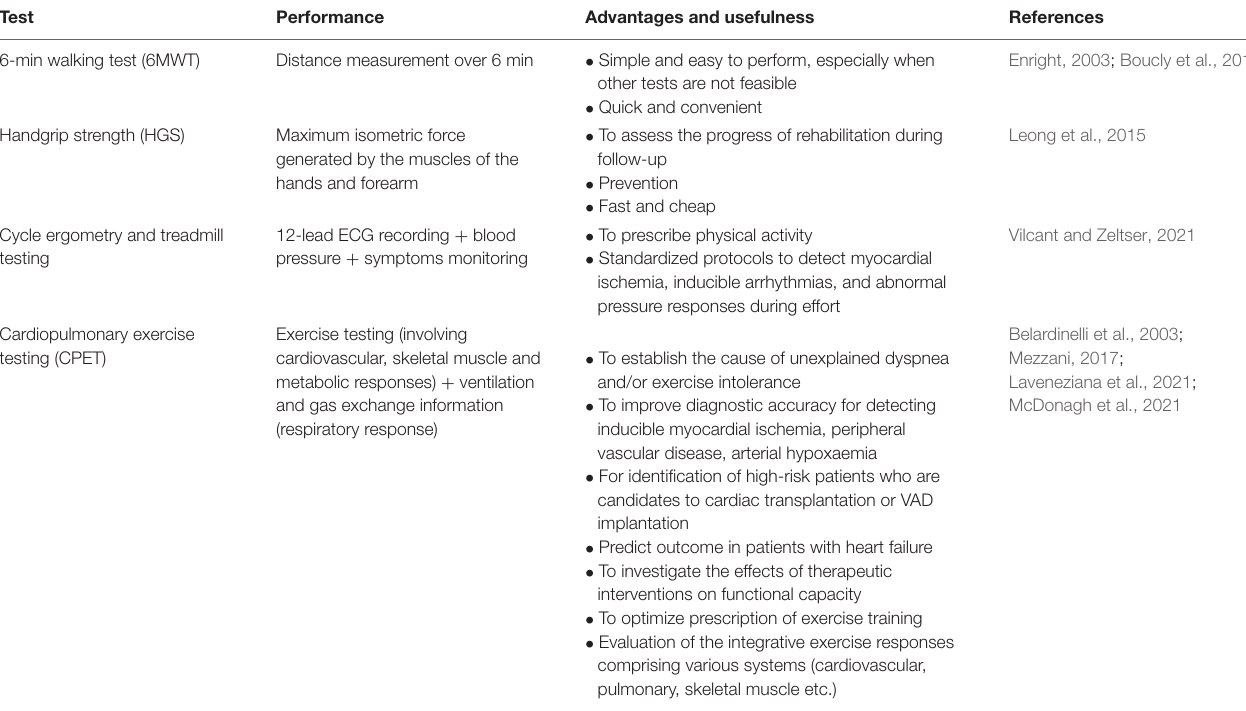
TABLE 1 | Summary of performances and benefits of different tests to assess patient